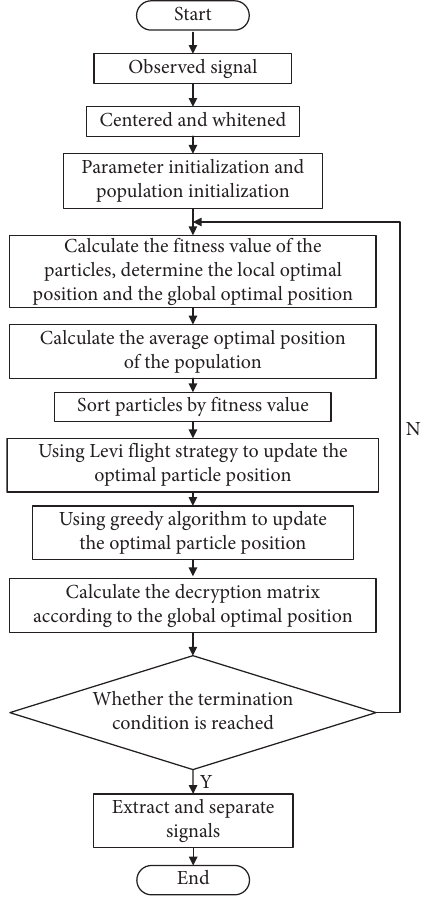
Figure 9: KLG-QPSO algorithm flow chart.